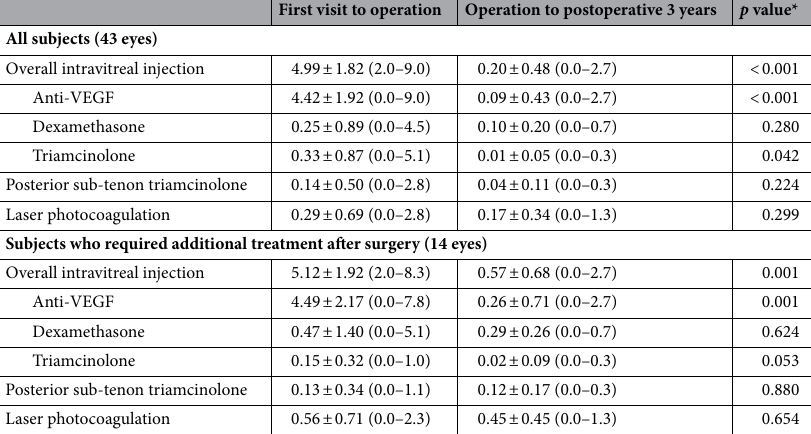
Table 2. Number of treatments for diabetic macular edema per year before and after vitrectomy combined with intraoperative dexamethasone implantation. VEGF, vascular endothelial growth factor. Variables are described as mean ± standard deviation (range). * p values were calculated using a generalized estimating equation accounting correlation structure for paired